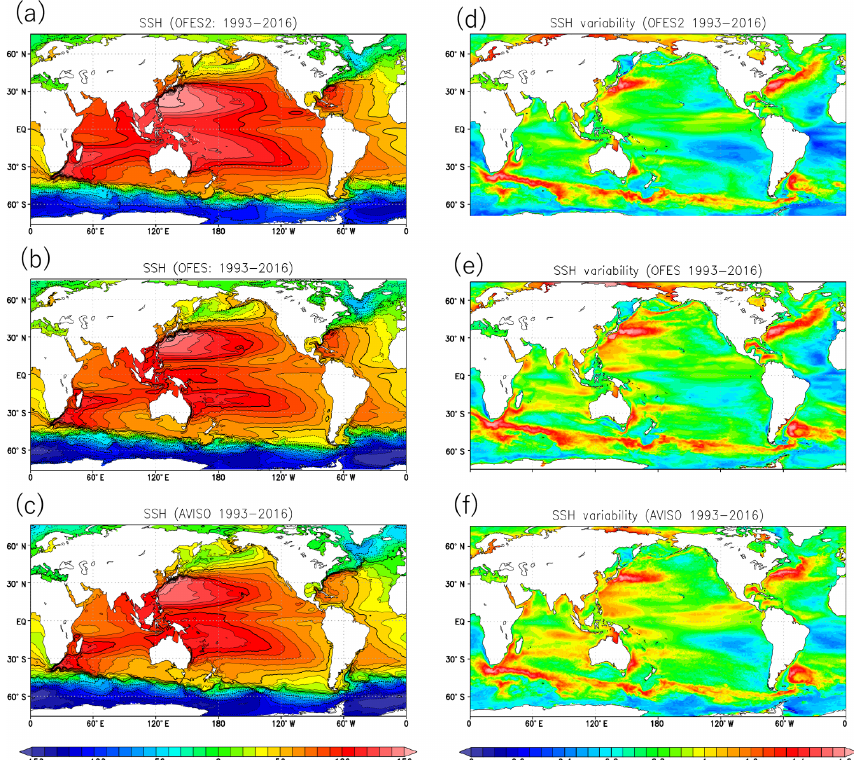
Figure 5. (a, b, c) Mean SSH (cm) and (d, e, f) its standard deviation (log10cm) averaged over 1993–2016 from (a, d) OFES2, (b, e) OFES, and (c, f) AVISO observations. The SSH in OFES2 and OFES was offset by adding 50cm.